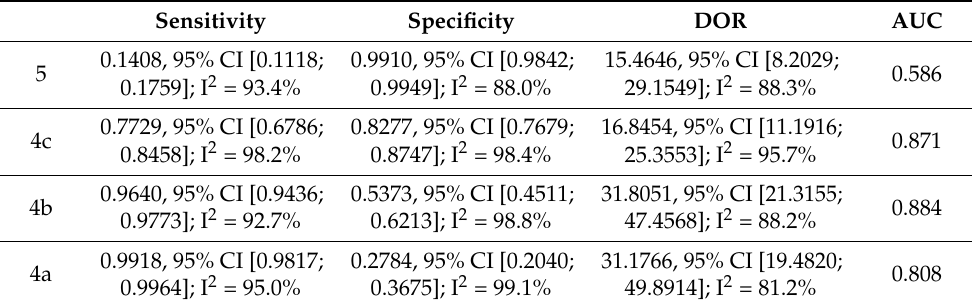
Table 1. Diagnostic efficacy and the ROC curves of Kwak TI-RADS categories.